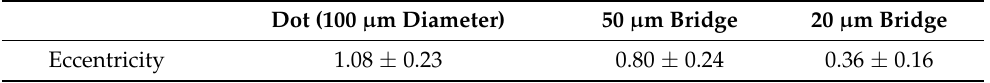
Table 1. Eccentricity of astrocytic clusters grown on different locations of the micrometric